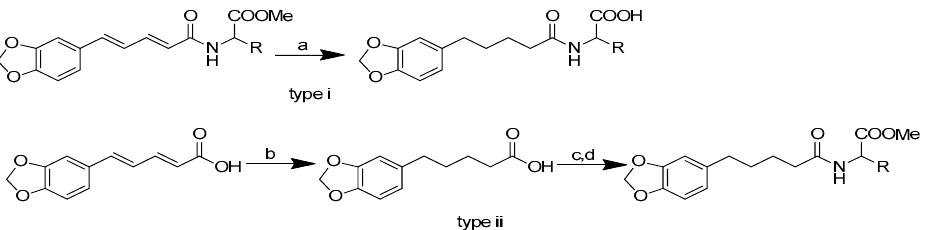
Table 1. Antileishmanial activity and cytotoxicity of piperoyl–amino acid conjugates. ( 1 ) Piperine;